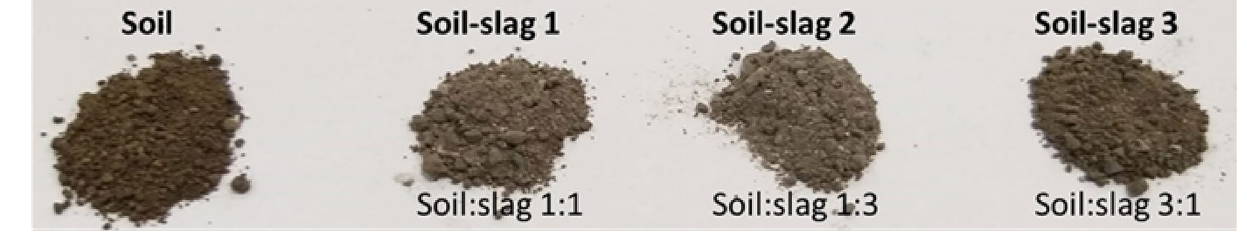
Figure 6. Images of mixtures of soil-slag